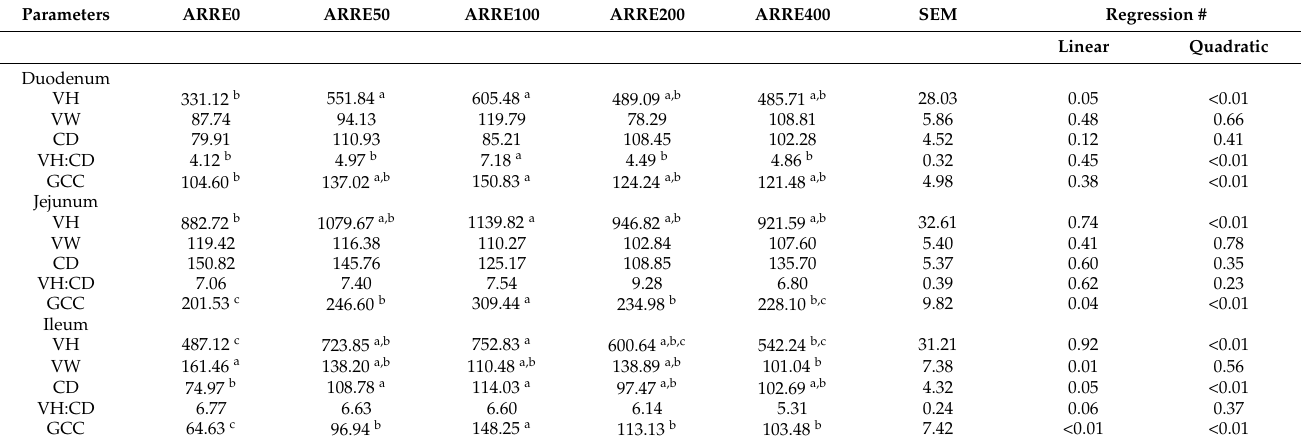
Table 5. The effect of dietary supplementation of ARRE on the morphometric measures ( µ m) of the small intestine of broiler